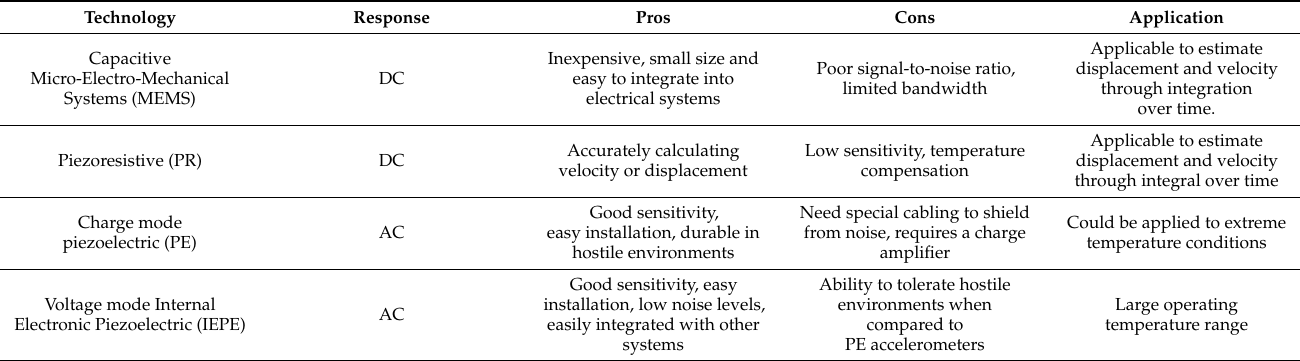
Table 1. Commonly available accelerometer types